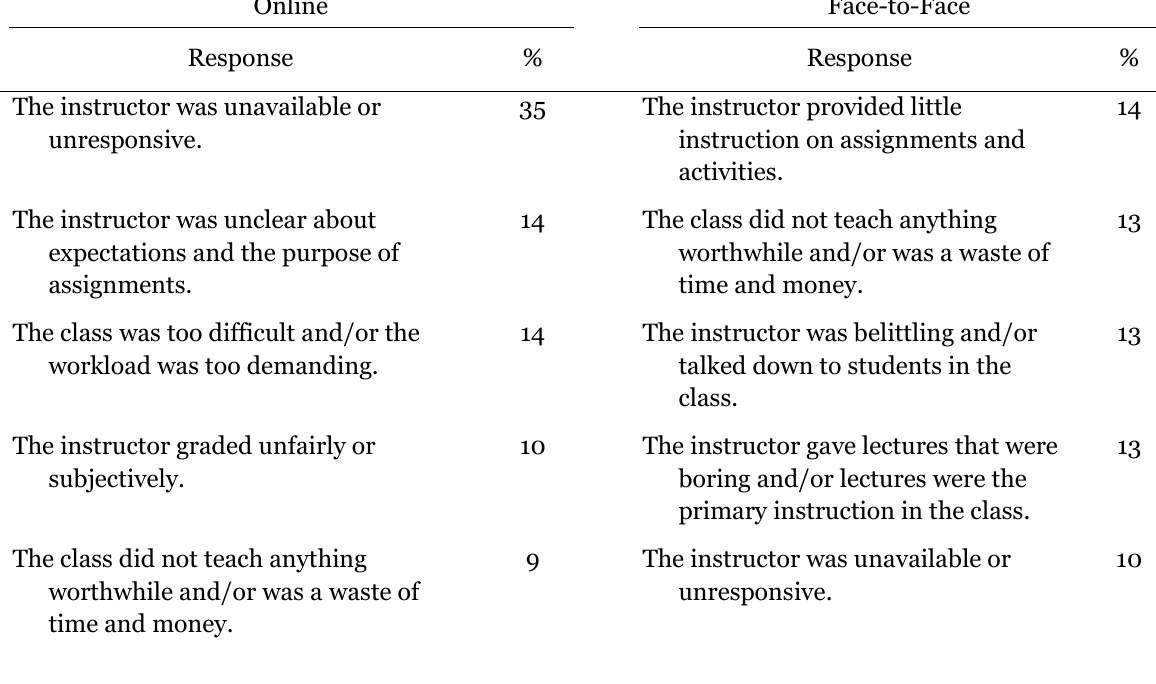
Prevalence of Open-Ended Comments Regarding What Makes a Class the Worst, by Modality Online Face-to-Face Response